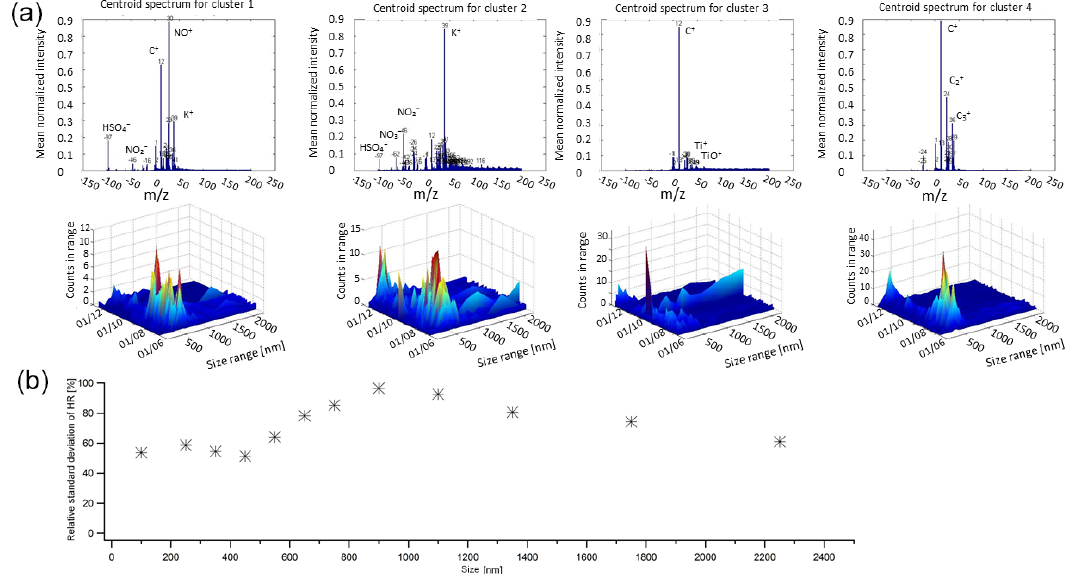
Figure 9. (a) Different clusters of particles and their evolution during the measurements in different size range between 10 and 2500nm. (b) The standard deviation of the total hit rate calculated every 5min during the measurements for each size